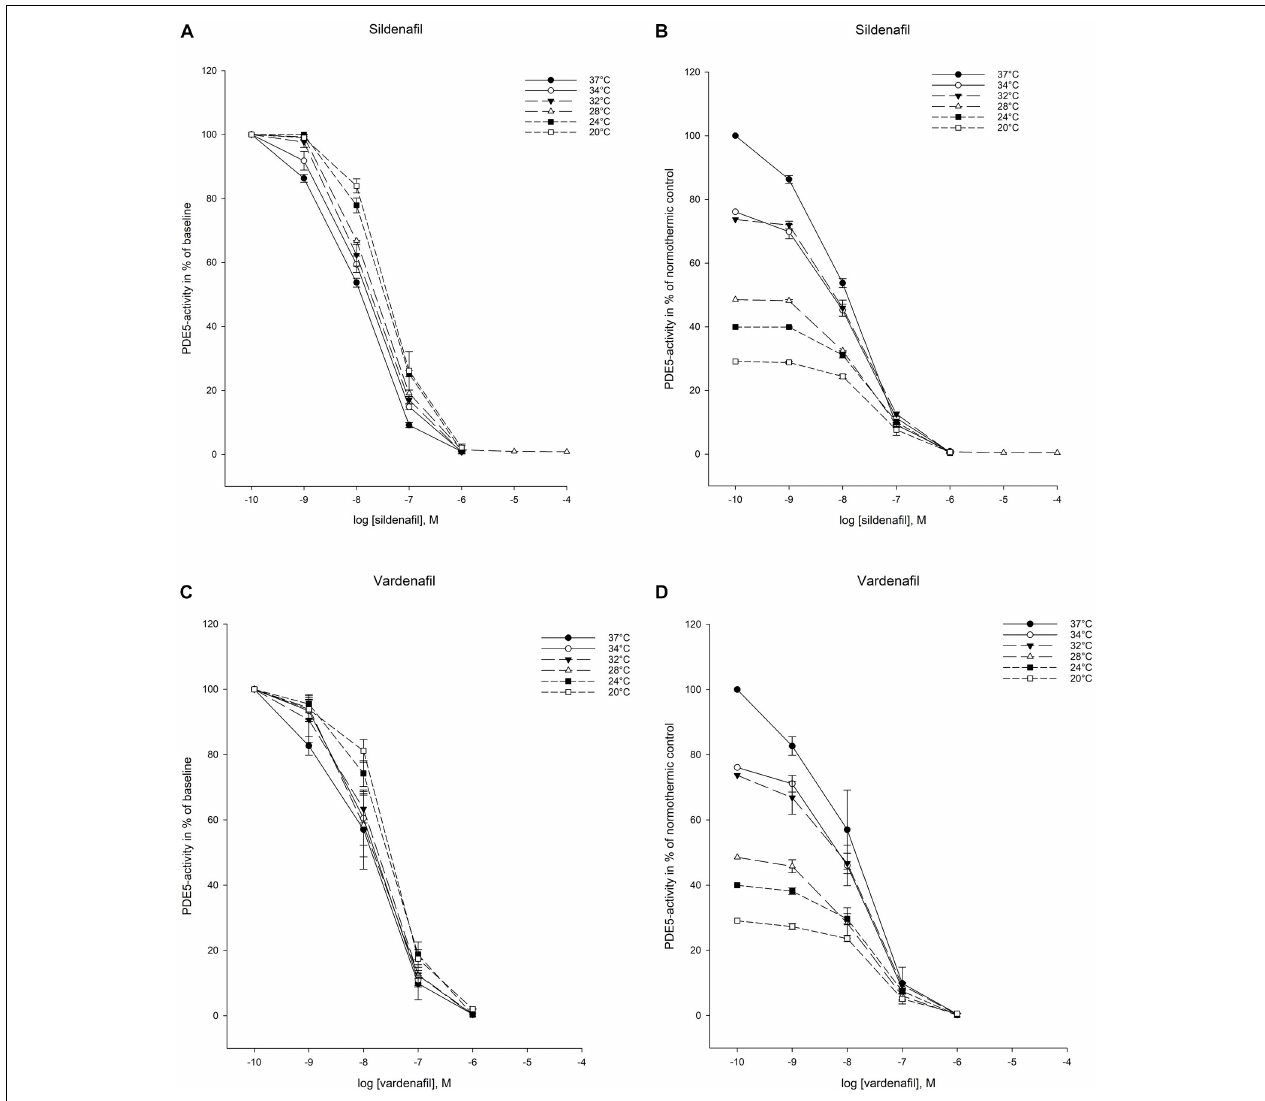
FIGURE 2 | Temperature-dependent inhibition of phosphodiesterase-5 (PDE5) by vardenafil and sildenafi. (A) Sildenafil inhibition curves for PDE5-activity at temperatures ranging from 37 ◦ C to 20 ◦ C. The doses of sildenafil are in logarithm of the concentration in mol/L. (B) Inhibition curves for PDE5-activity by sildenafil in % of normothermic inhibition curve at temperatures ranging from 37 ◦ C to 20 ◦ C. The doses of sildenafil are in logarithm of the concentration in mol/L. (C) Vardenafil inhibition curves for PDE5-activity at temperatures ranging from 37 ◦ C to 20 ◦ C. The doses of vardenafil are in logarithm of the concentration in mol/L. (D) Inhibition curves for PDE5-activity by vardenafil in % of normothermic inhibition curve at temperatures ranging from 37 ◦ C to 20 ◦ C. The doses of vardenafil are in logarithm of the concentration in